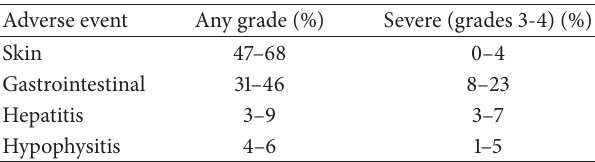
Table 3: Frequency of adverse events with 10 mg/kg dose of